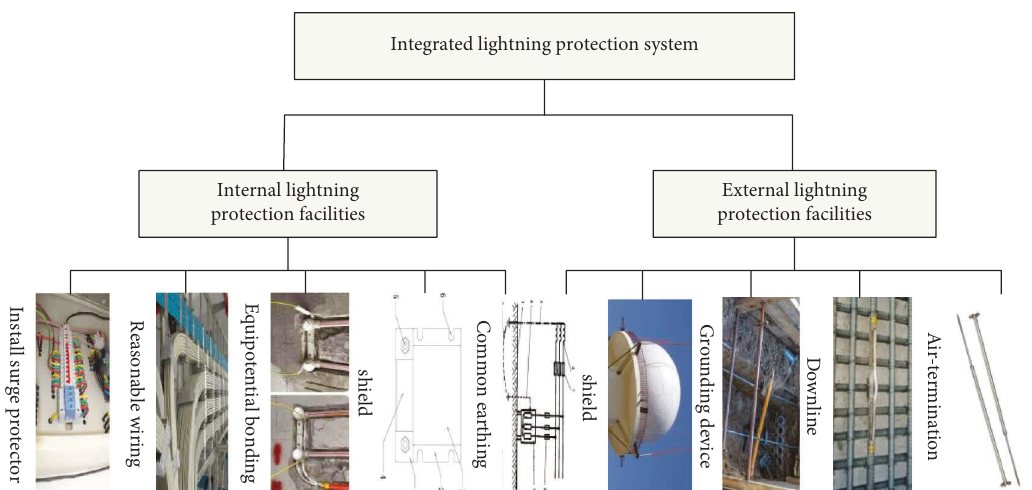
Figure 4: Comprehensive lightning protection system